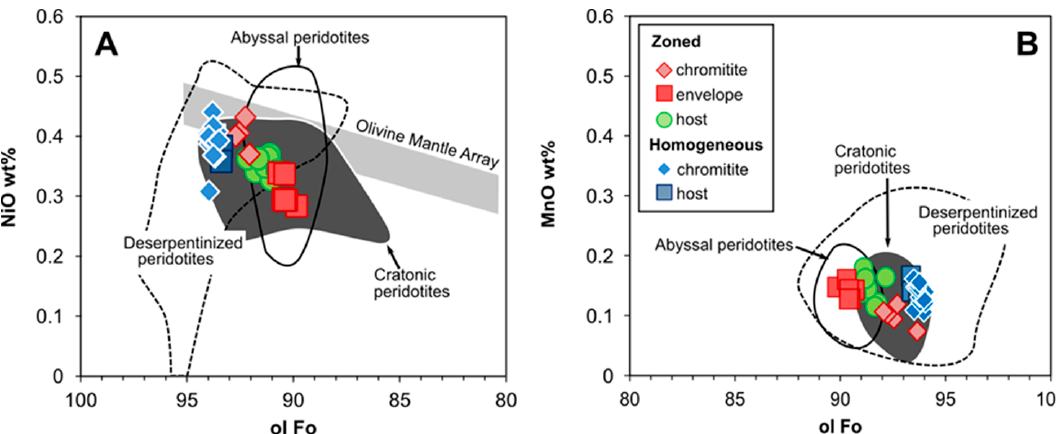
those with the zoned chromites (Figure 5A). The olivine MnO contents in both types of chromites are almost similar.